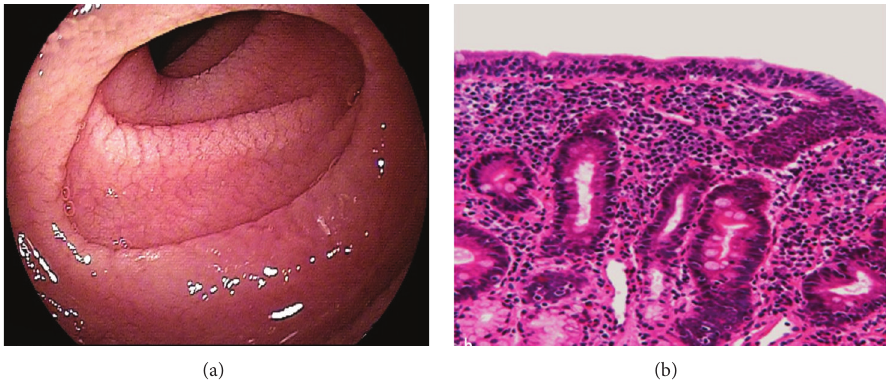
Figure 1: Endoscopic (a) and histologic (b) features found in RCD. Endoscopic abnormalities found in RCD include scalloped configuration of folds and fissuring with a mosaic pattern (a). Biopsies processed for histology show villous atrophy, crypt hyperplasia and increased infiltration of lymphoid cells in the epithelium